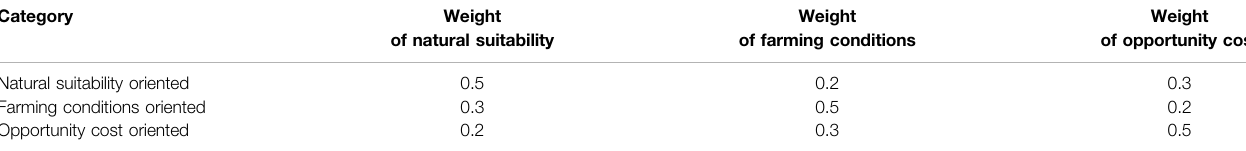
TABLE 4 | Weighted veri fi cation scheme based on different combinations.